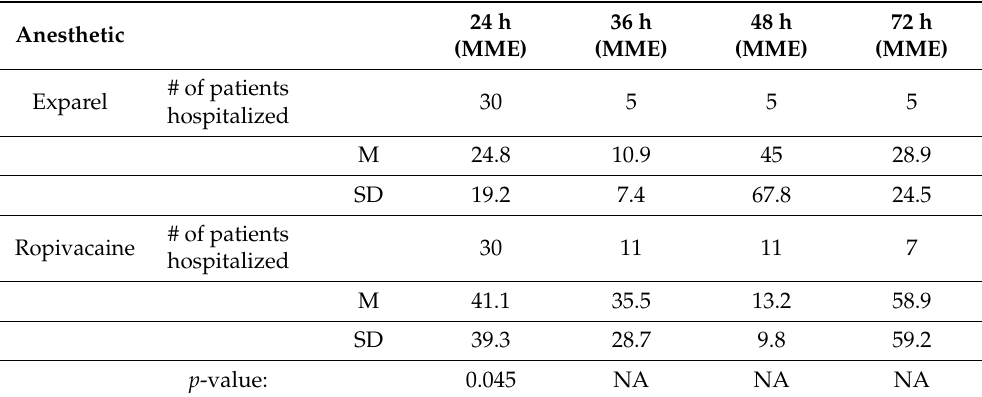
Table 2. Morphine milligram equivalents (MME) measured at postoperative times after PACU